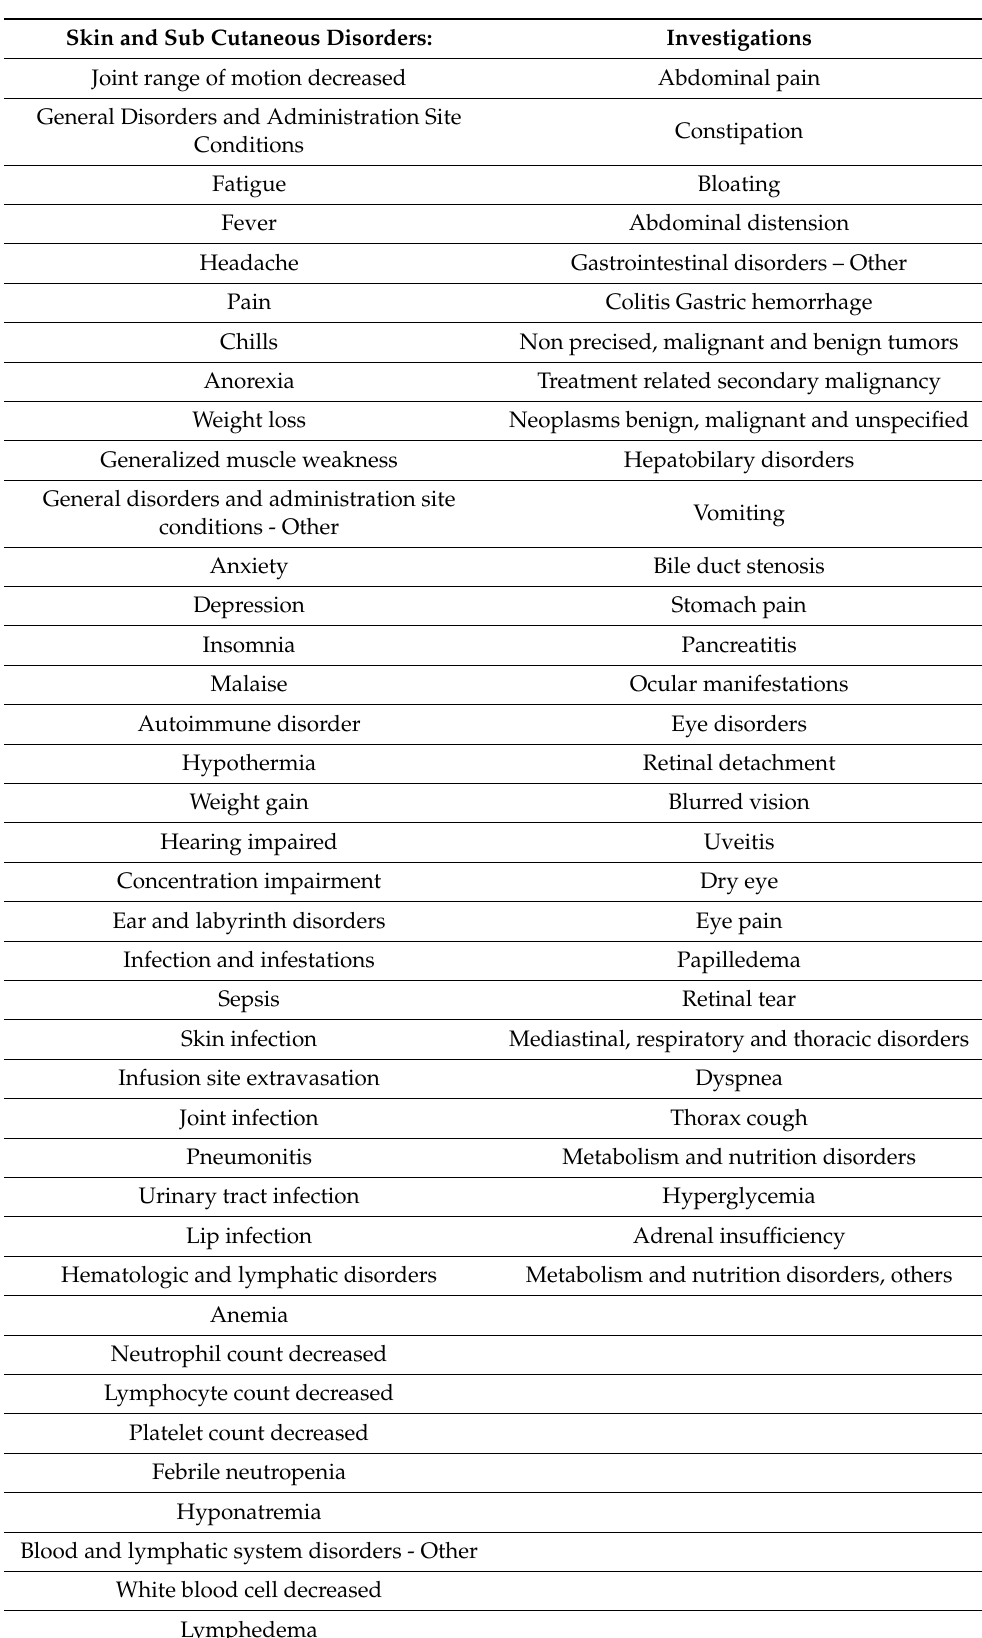
Table A1. Cont. Skin and Sub Cutaneous